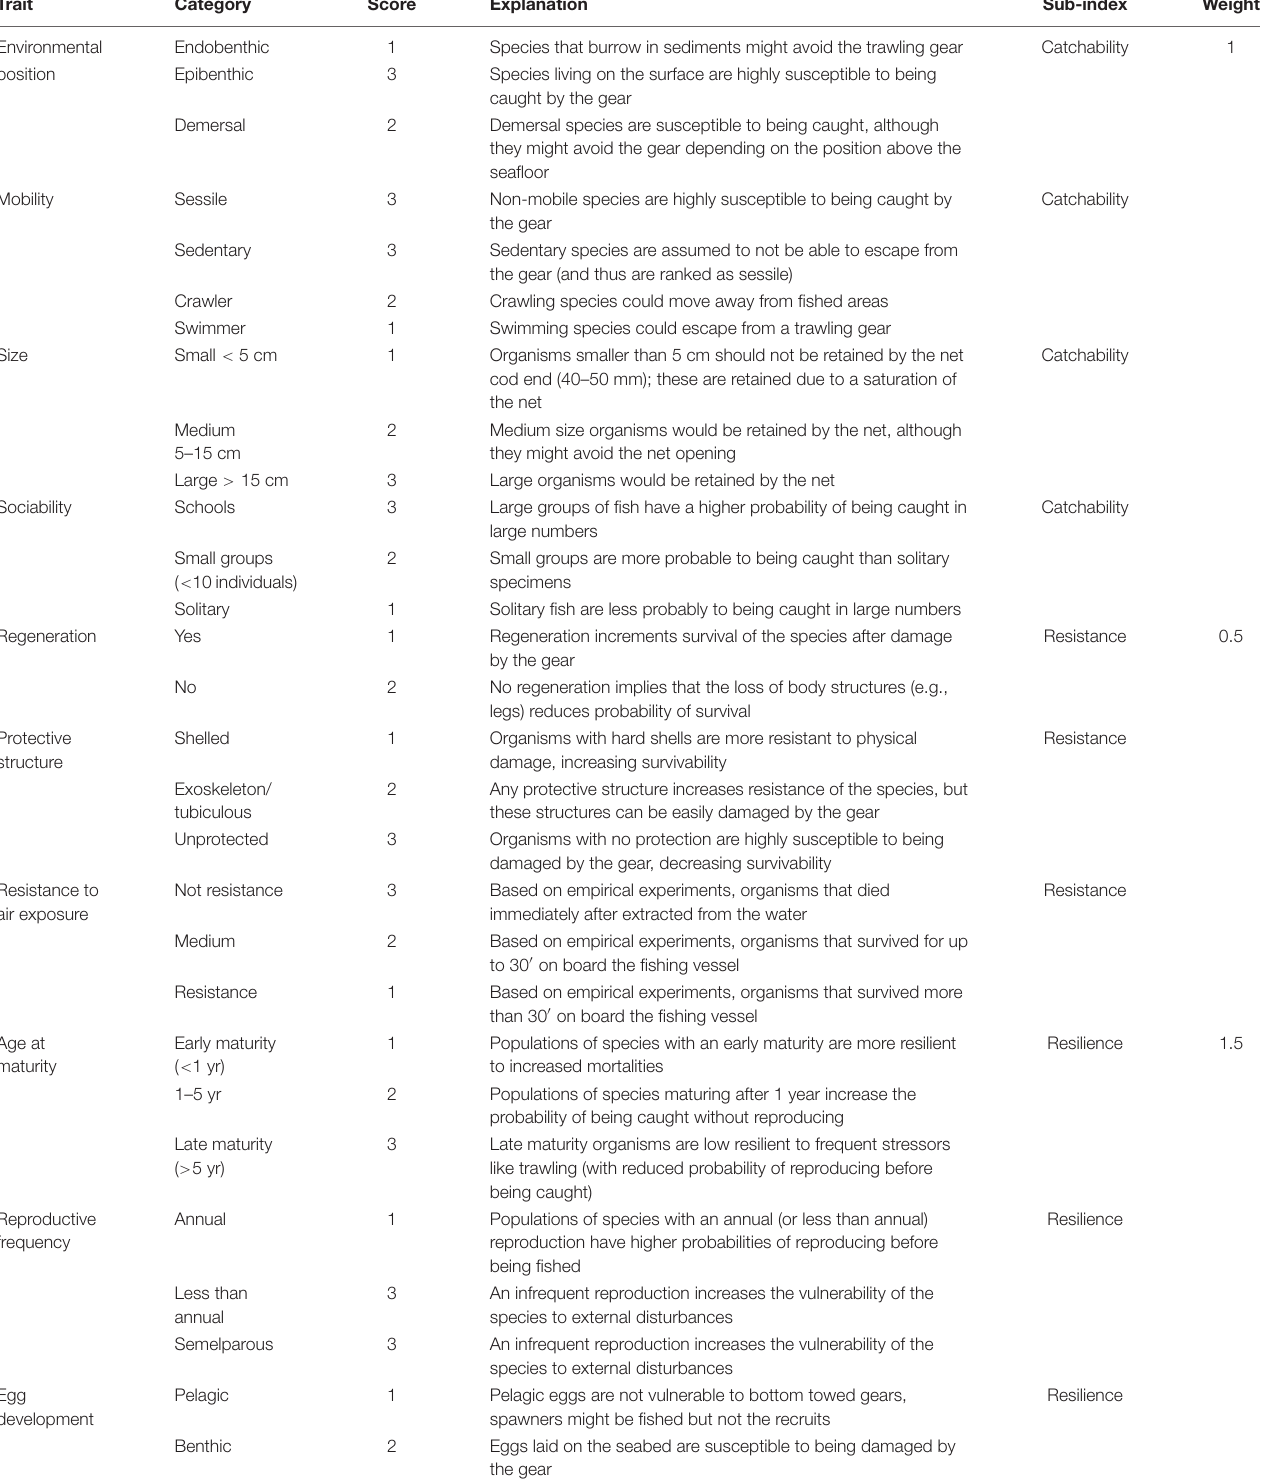
TABLE 1 | Summary of traits, traits’ categories and sub-indices, including the category scores and sub-index weight and the justification for score/weight assignation. Trait Category Score